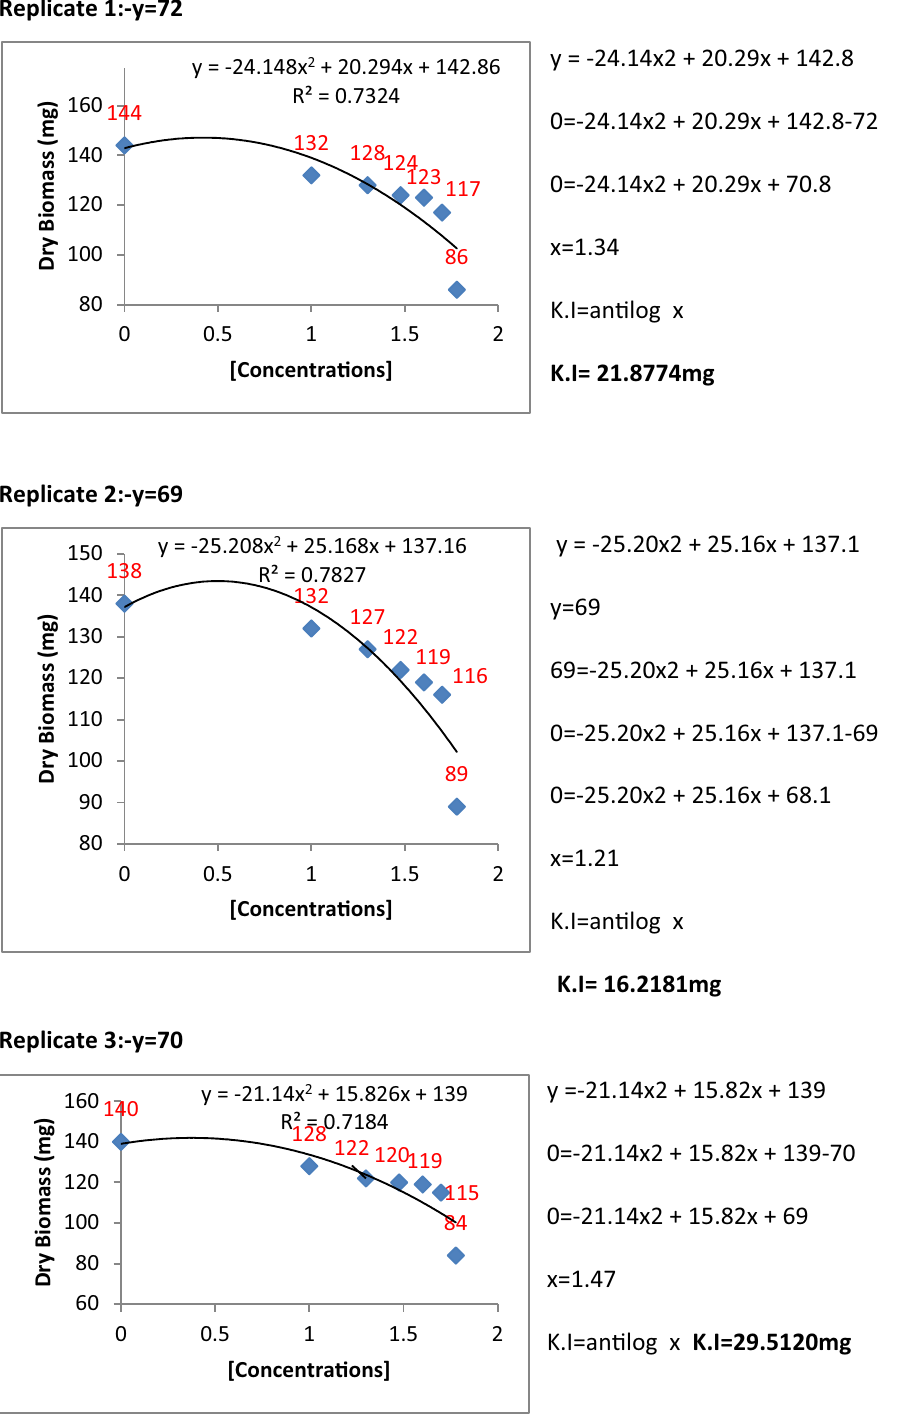
Figure 11. Kinetic constants of inhibition of P. herbarum by metabolites of P. janczewskii (3